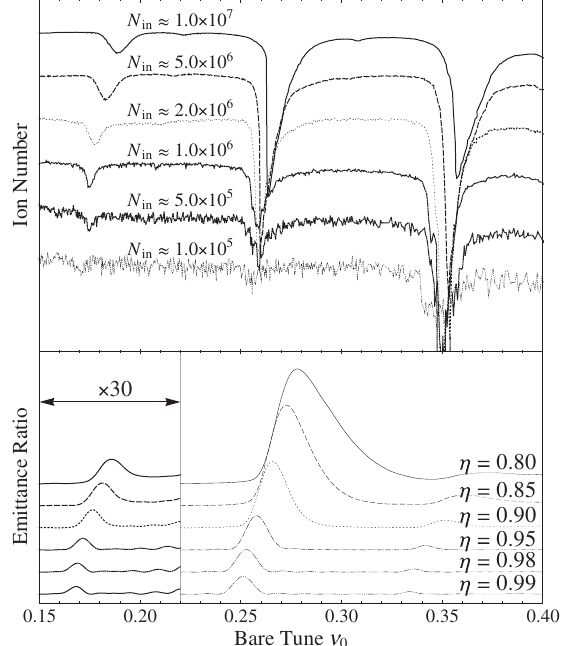
FIG. 9. Comparison between the stop-band distributions obtained through S-POD experiments and WARP simulations. The plasma storage periods are fixed at 10 msec in the experi- ments and at 0.1 msec in the simulations. The initial ion number N in is chosen in the range 10 5 (cid:4) N in (cid:4) 10 7 . The weak stop band near (cid:5) 0 ¼ 1 = 6 is 30 times enlarged in the lower panel. The scale of the ordinate is